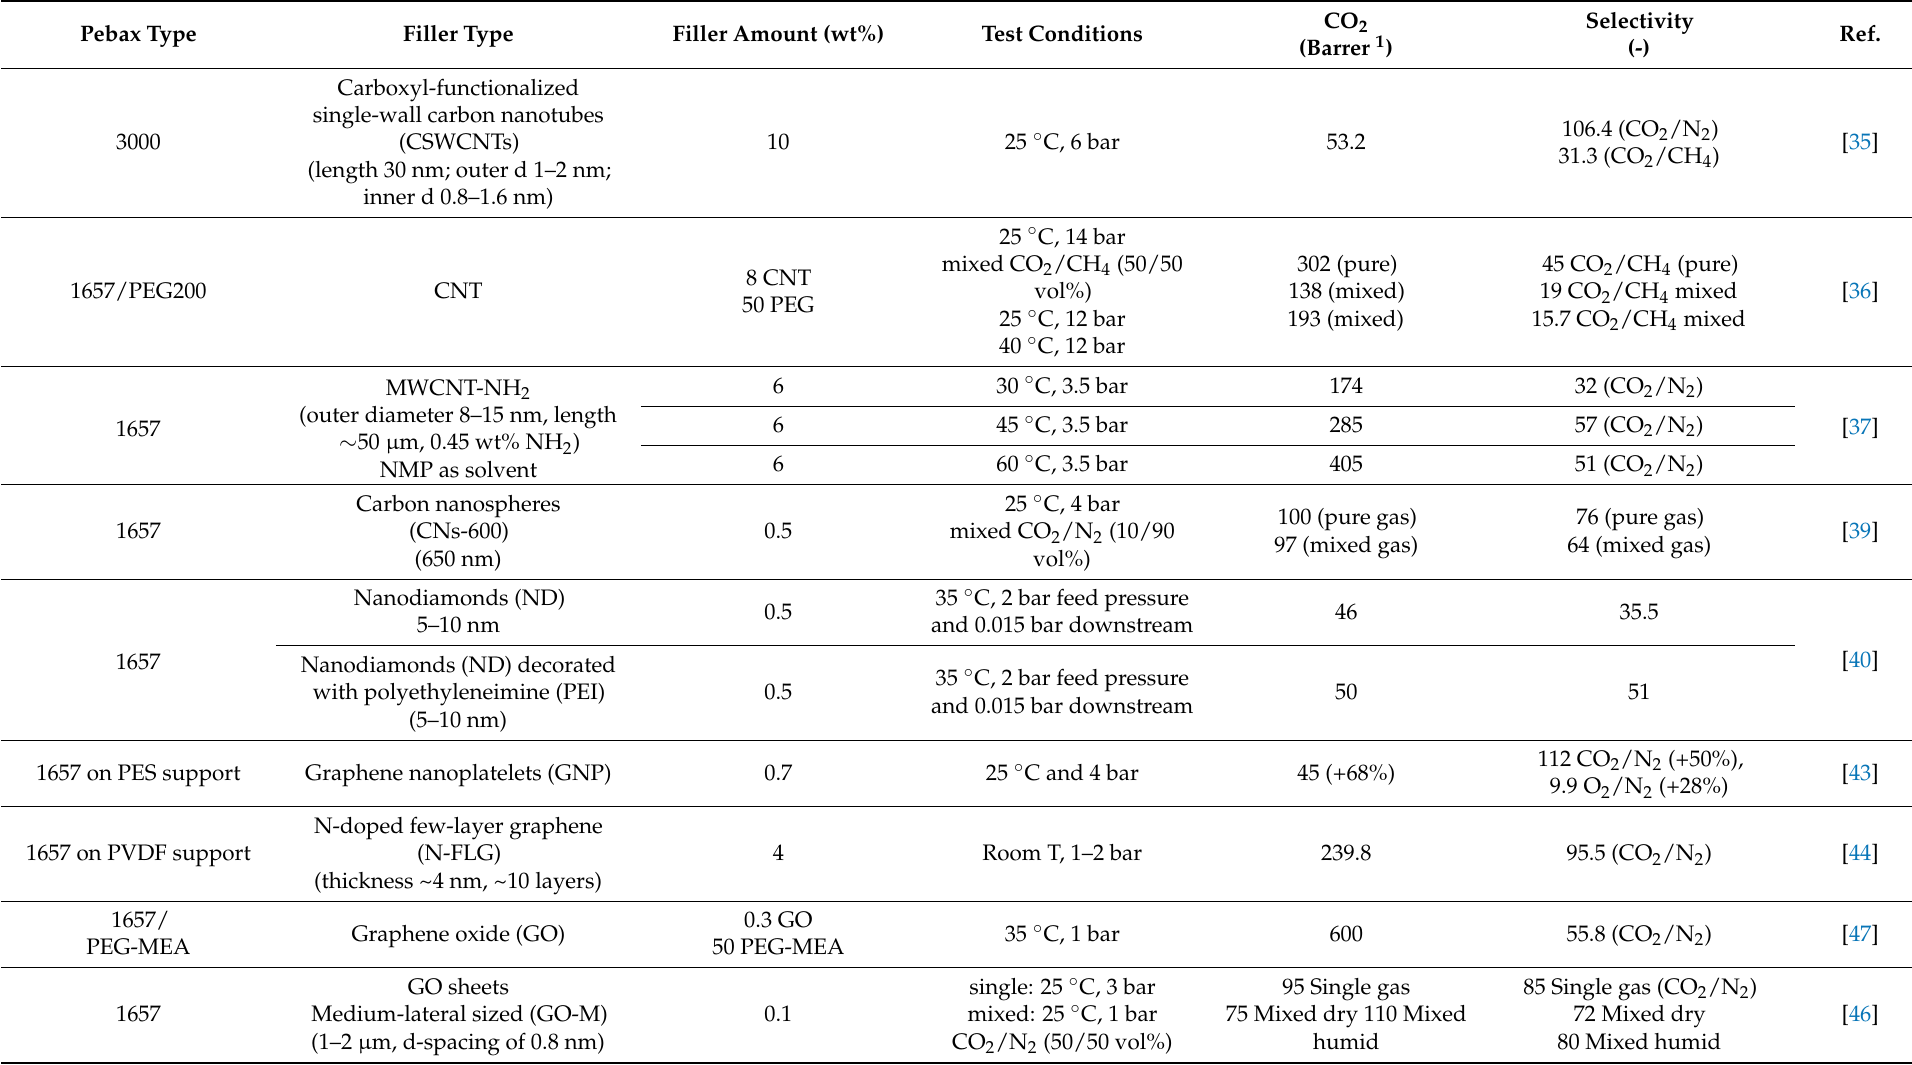
Table 5. Permeation properties of selected Pebax-based MMMs filled with carbon